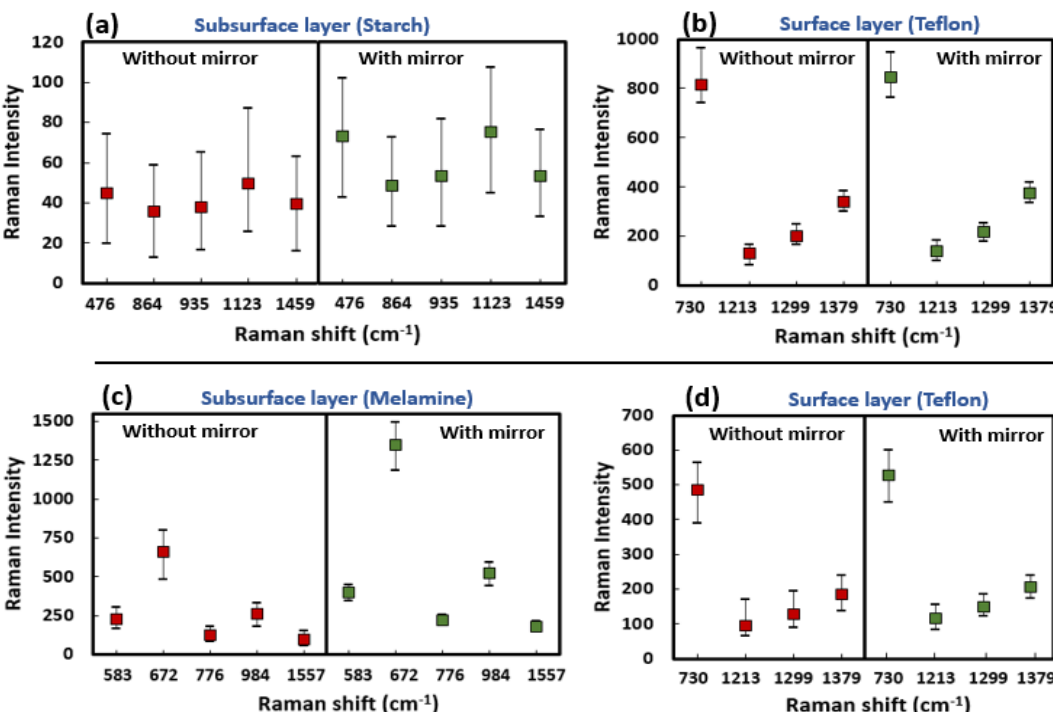
Figure 4. Box plots showing the distribution of magnitudes of Raman signal increases for the subsurface layer on a mirror: subsurface ( a ) and surface layer ( b ) of S1, and subsurface ( c ) and surface layer ( d ) of S2. (This figure is the box plot representation of Figure 3 with additional wavebands).